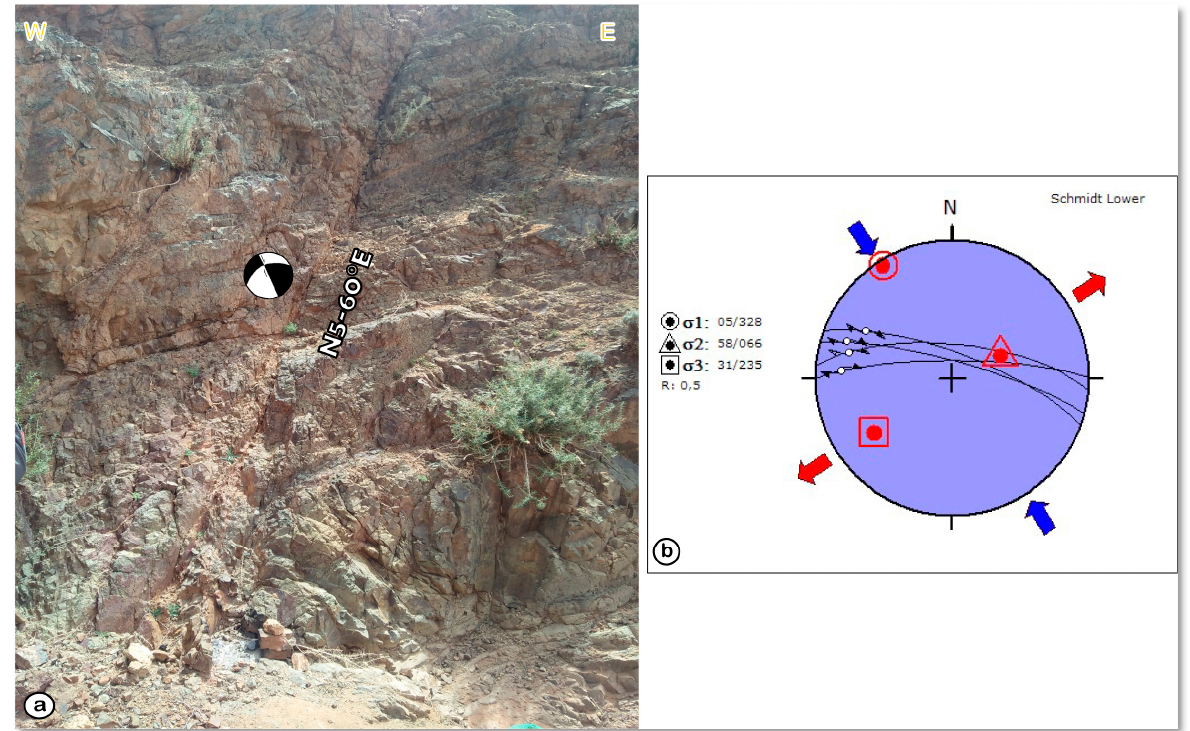
Figure 7. ( a ) Field photograph showing a dextral strike-slip affecting the Ouarzazate Group volcani- canosedimentary units. ( b ) Stereographic projection of the fault analysis and the interpreted stress axis during the compressive brittle deformation of the early Ediacaran.